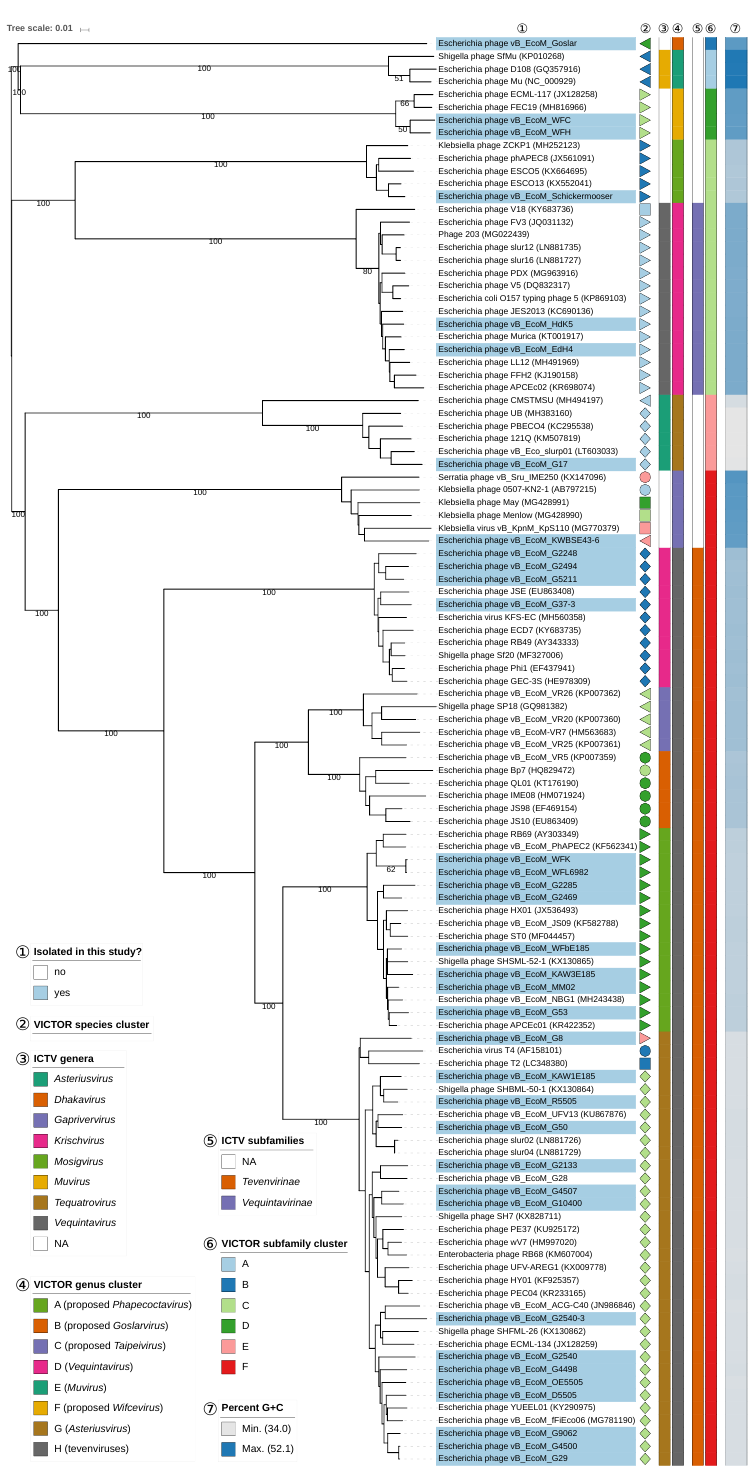
Figure 7. Phylogenomic analysis of Myoviridae members of this study at the amino acid level using VICTOR. The recommended VICTOR tree (formula d 6 ) is shown and the numbers above branches are GBDP pseudo-bootstrap support values from 100 replications, given that branch support exceeds 50%. The branch lengths of the resulting VICTOR trees are scaled in terms of the used distance formula. Annotations are given to the right-hand side of the tree: indicator for newly isolated phages (1), genera and subfamilies according to ICTV (3,5), species, genus, and subfamily cluster proposed by VICTOR (2,4,6), and genomic G + C content